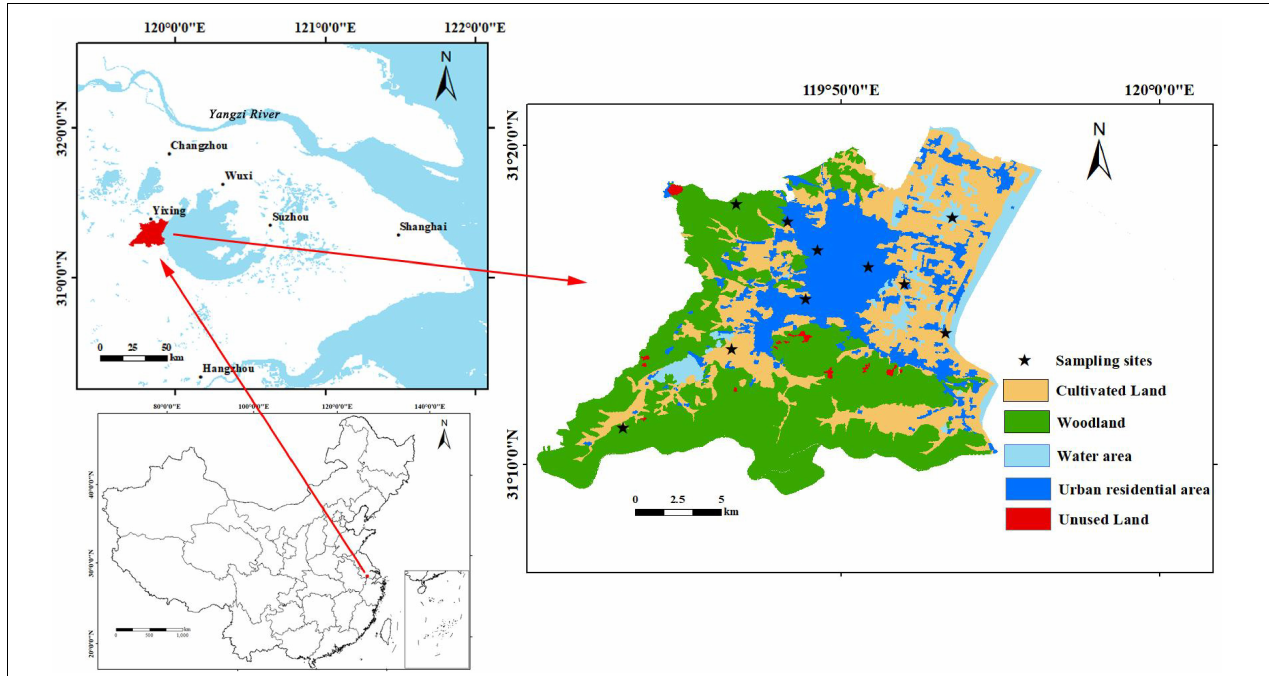
FIGURE 1 | Study area and sampling